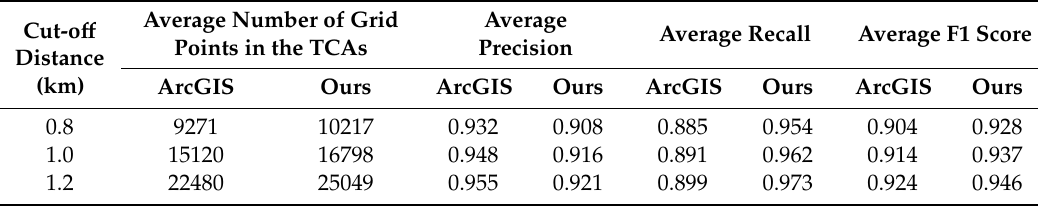
Table 1. The statistics for 32 stations under di ff erent cut-o ff distances.